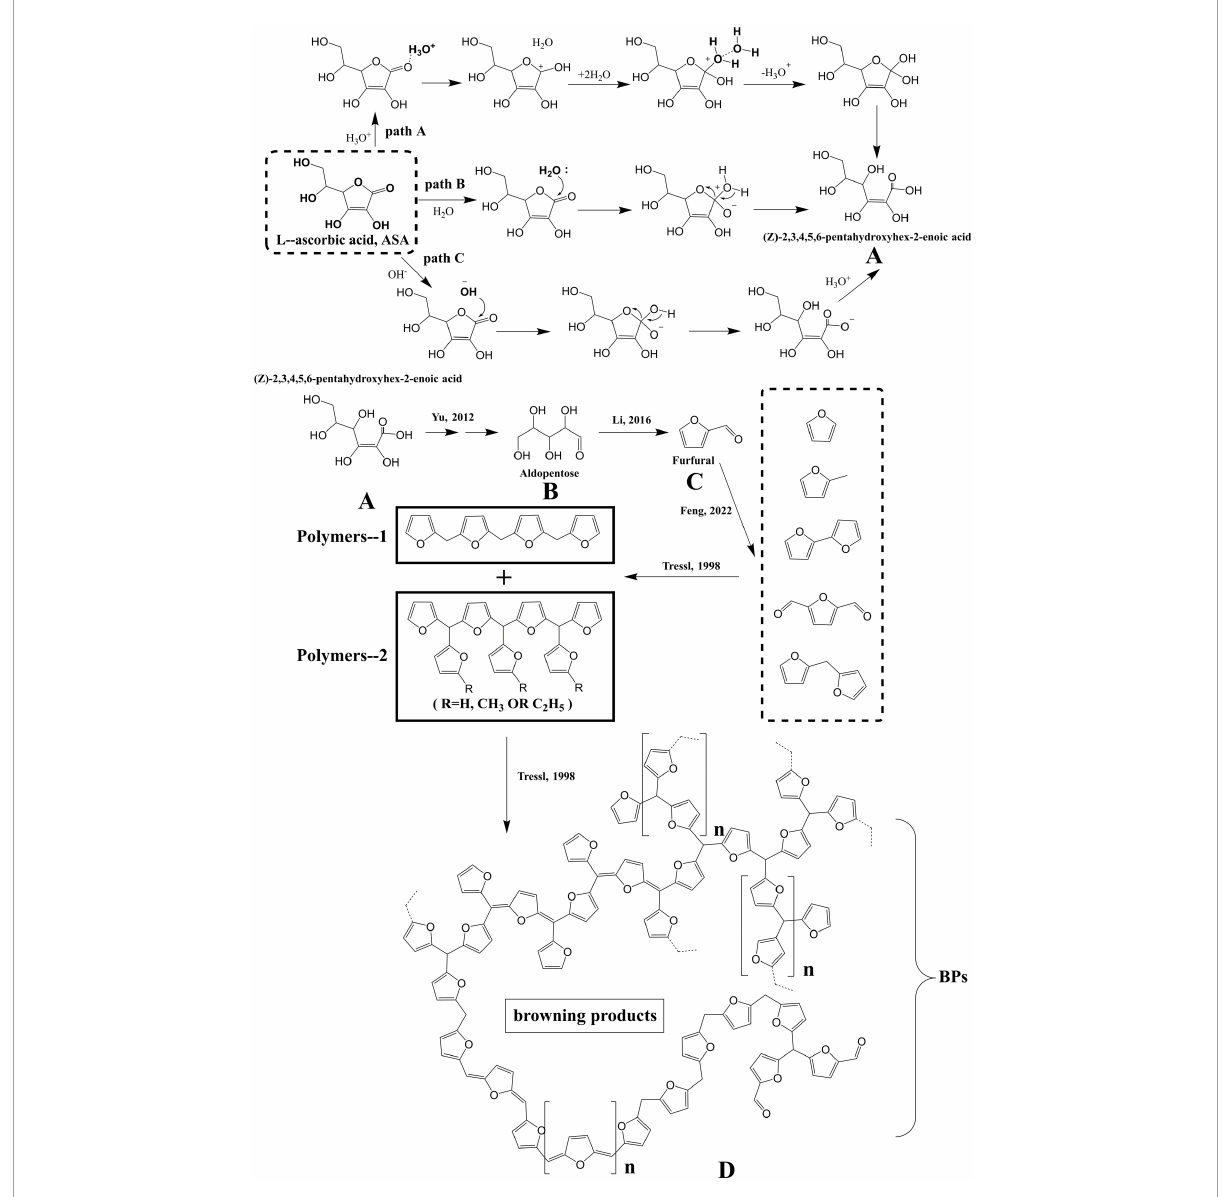
FIGURE4 The possible mechanism of hydrolysis mechanism of ASA and formation of BPs. (A) (Z)-2,3,4,5,6-pentahydroxyhex-2-enoic acid, (B) aldopentose, (C) furfural, and (D) browning